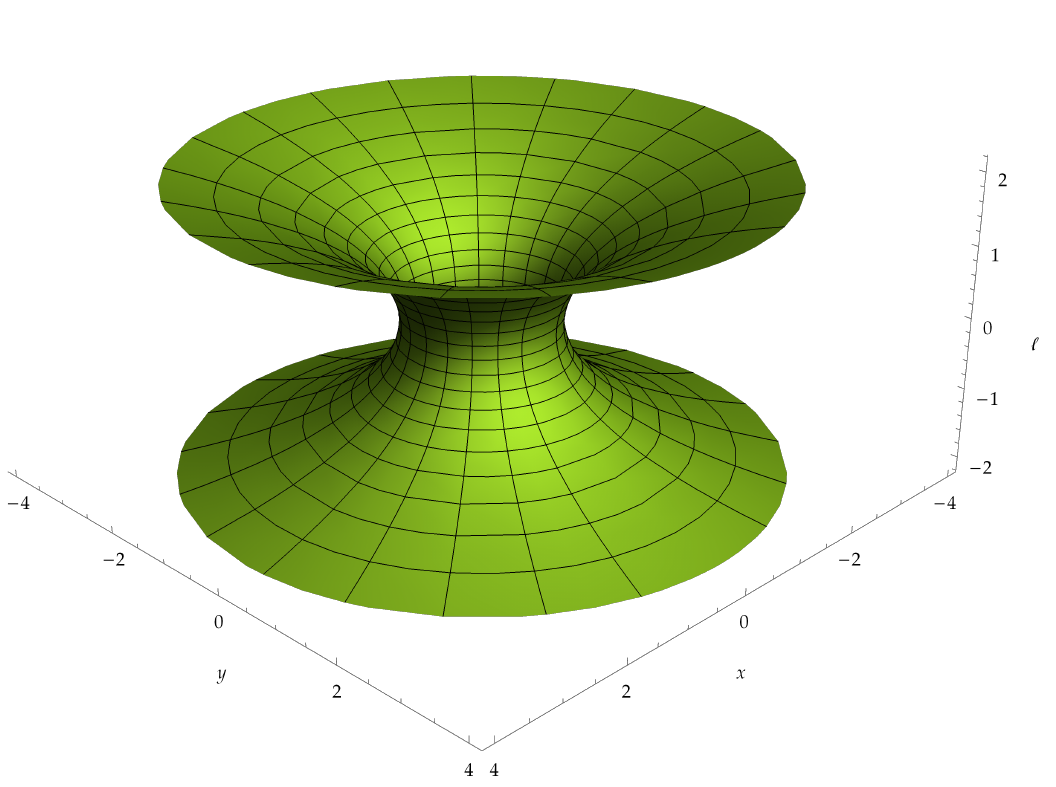
Figure 6: A slice of the wormhole geometry at the equator, θ = π/ 2, and at a constant value of t . The upper universe corresponds to (cid:96) → + ∞ , while the lower universe (which we will assume is another part of the same universe) corresponds to (cid:96) → −∞ . Note that each circle is actually a slice of a sphere; we are simply suppressing other values of θ on the sphere so that we can plot the wormhole in three